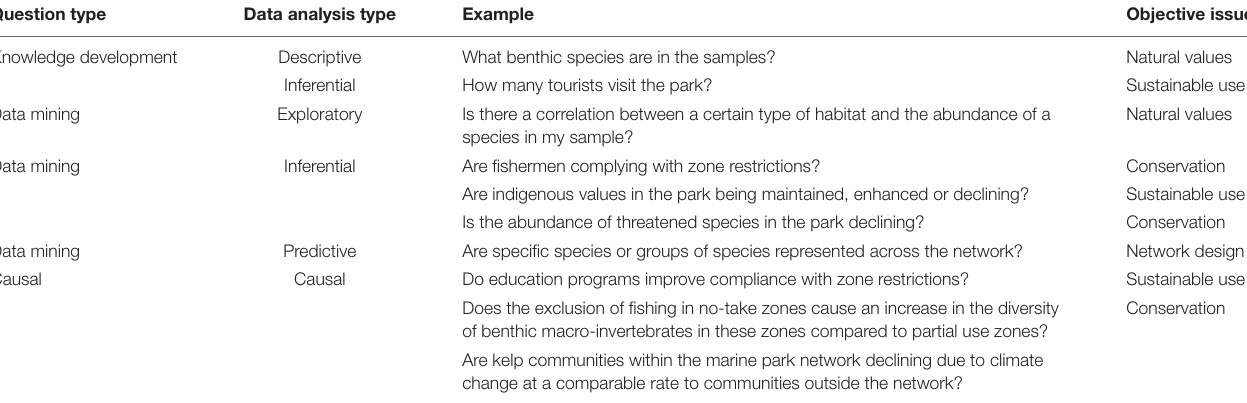
TABLE 1 | Examples of the types of questions, objectives issue and associated data analysis type, that managers might ask of an individual MPA or of a MPA